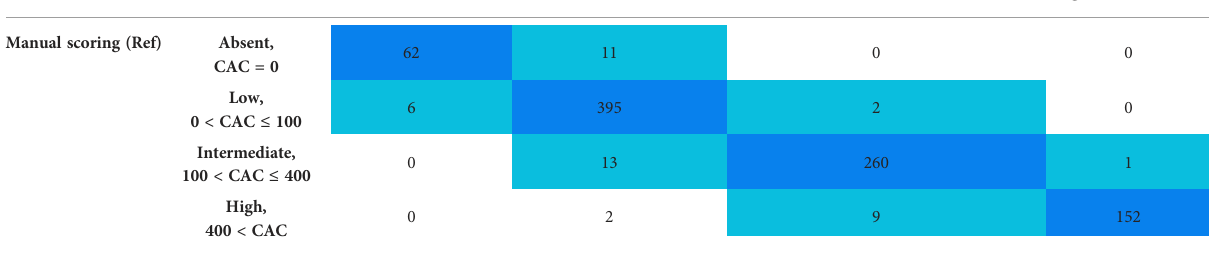
TABLE 3 Reliability of CAC-based risk strati fi cation using deep learning-based fully automated software and manual scoring on chest computed tomography. Deep learning-based fully automated